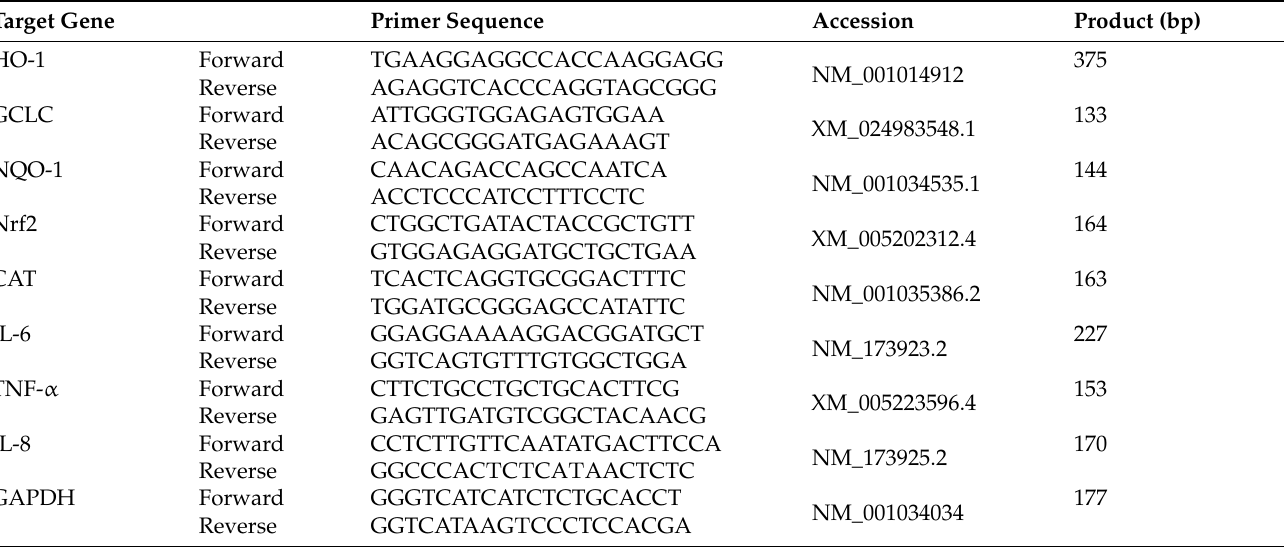
Table 2. PCR Primers Used for the Quantification of the Candidate Genes in